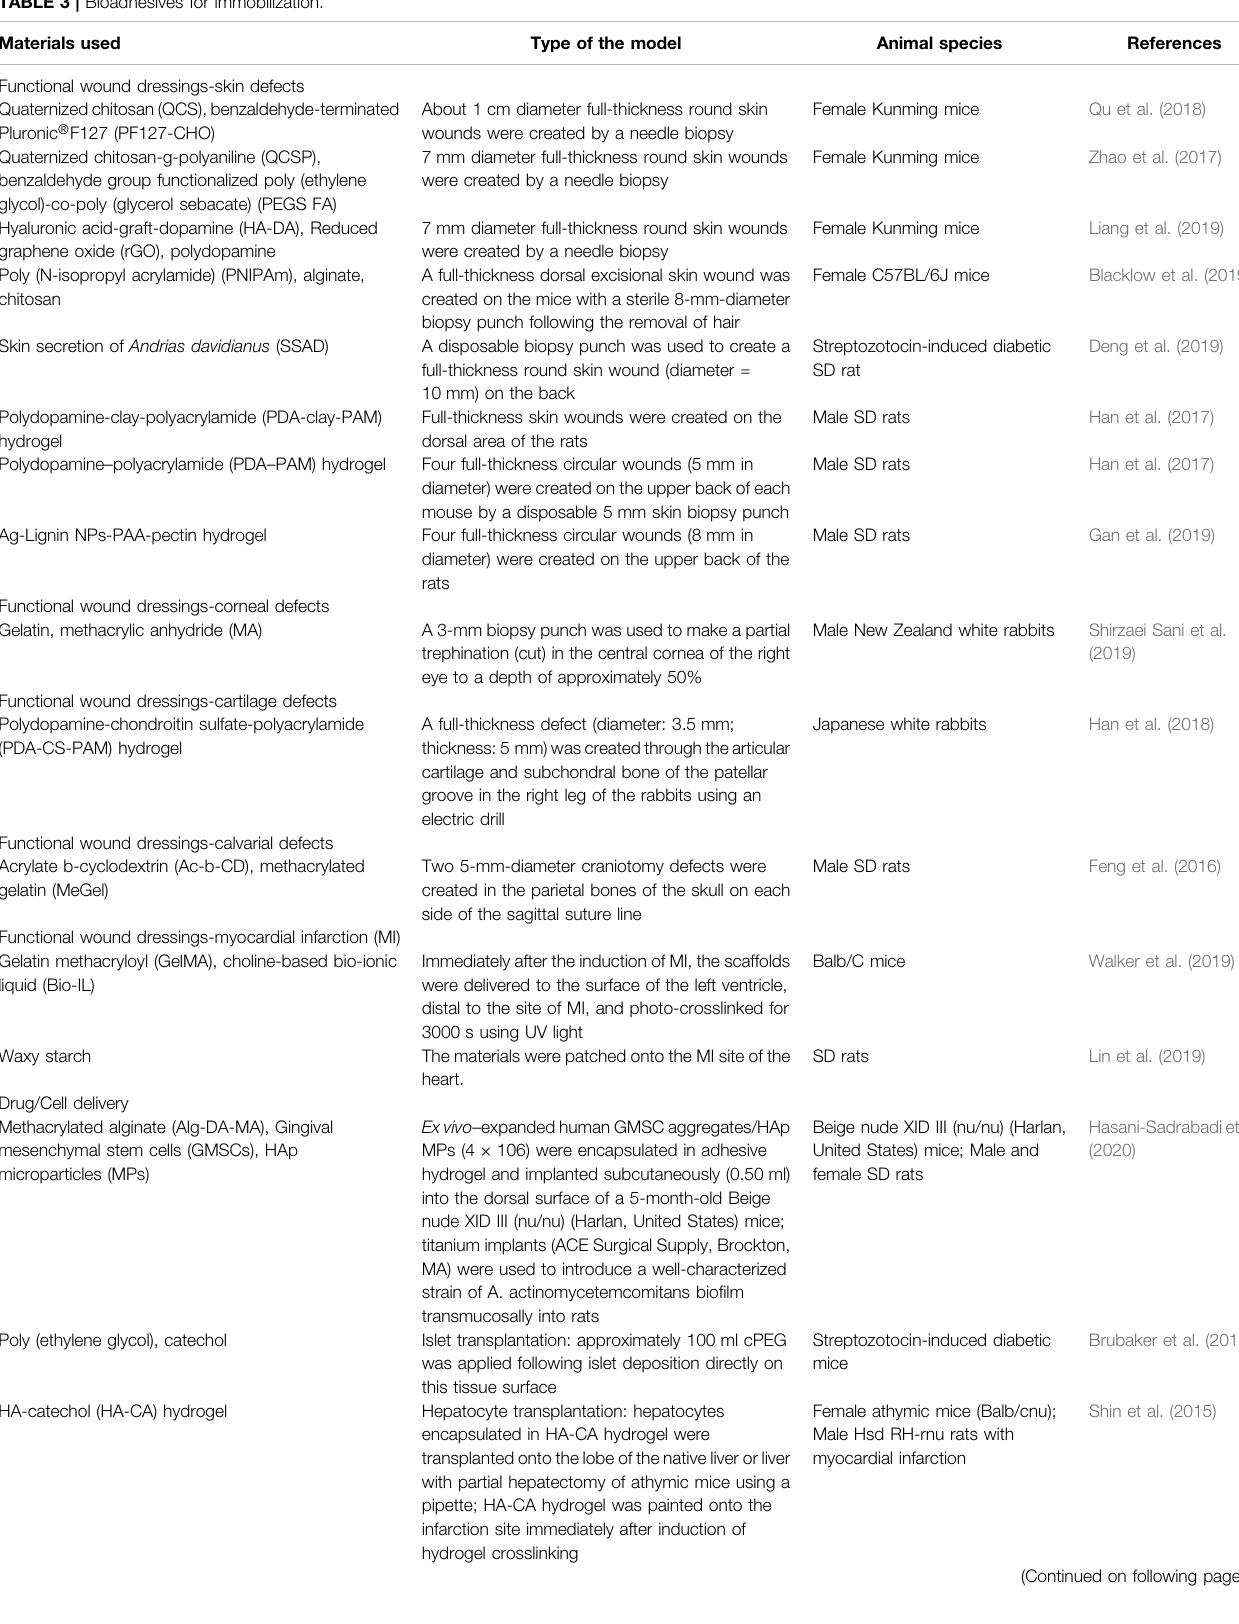
TABLE 3 | Bioadhesives for immobilization. Materials